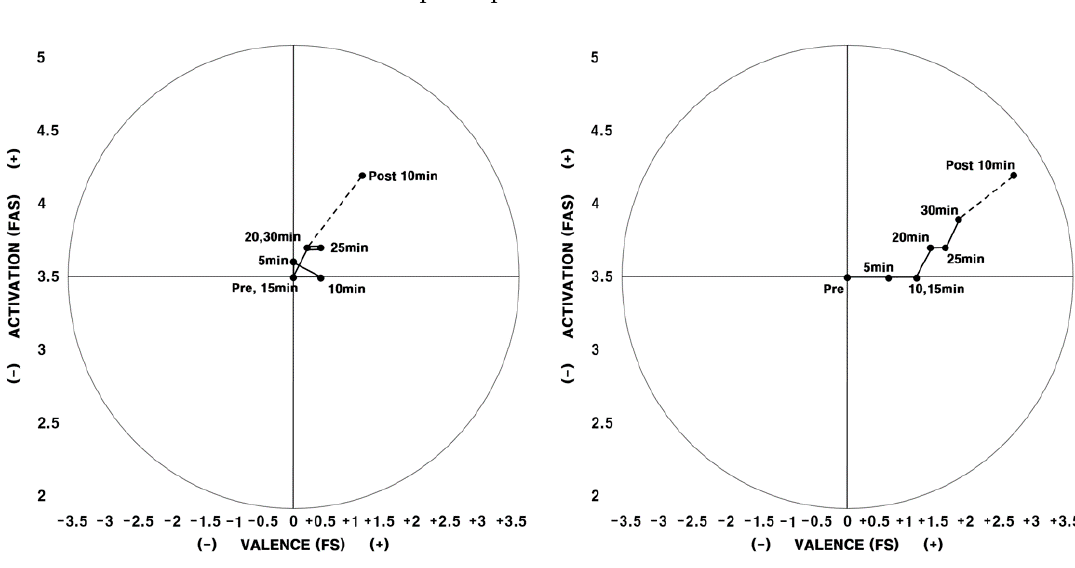
Figure 1. 2D circumplex model (average FAS and FS of all participants) Note. Left: 1st experiment / Right: 2nd experiment. FAS: felt arousal scale; FS: feeling scale.